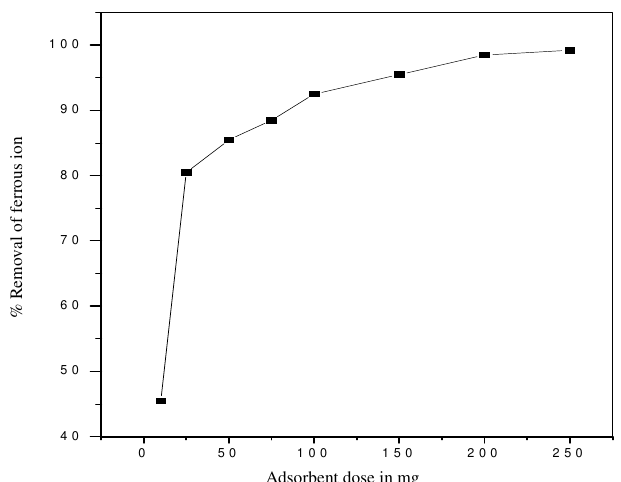
Figure 2. Effect of adsorbent dose on the adsorption of ferrous ion onto ZDC [M] = 15 mg/L, Contact time = 60 min; temp = 30 o C Adsorption isotherm